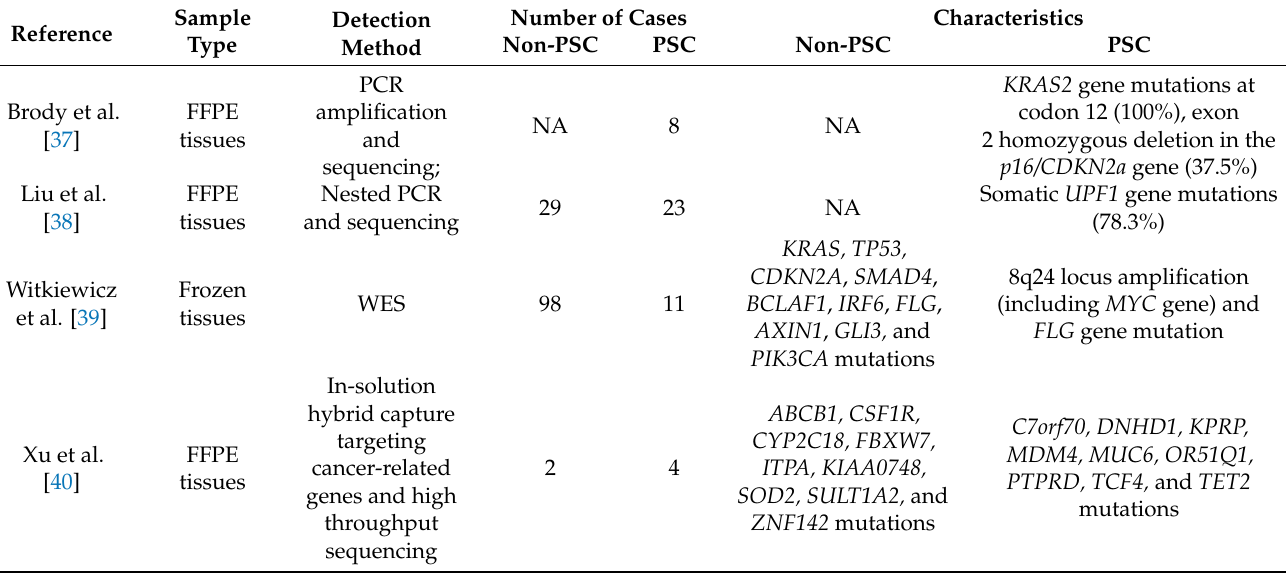
Table 1. A comparison of the genetic features between PSC and non-PSC